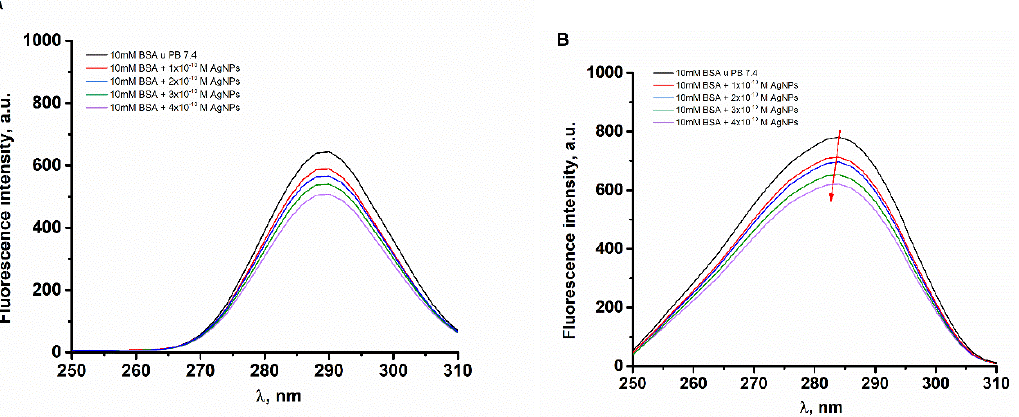
Figure 4. The synchronous fluorescence spectra of 1 × 10 − 5 M BSA in the absence and the presence of increasing AgMet concentration (1 × 10 − 10 –4 × 10 − 10 M) in 10 mM phosphate buffer, pH 7.4. ( A ) Δλ = 15 nm and ( B ) Δλ = 60 nm.